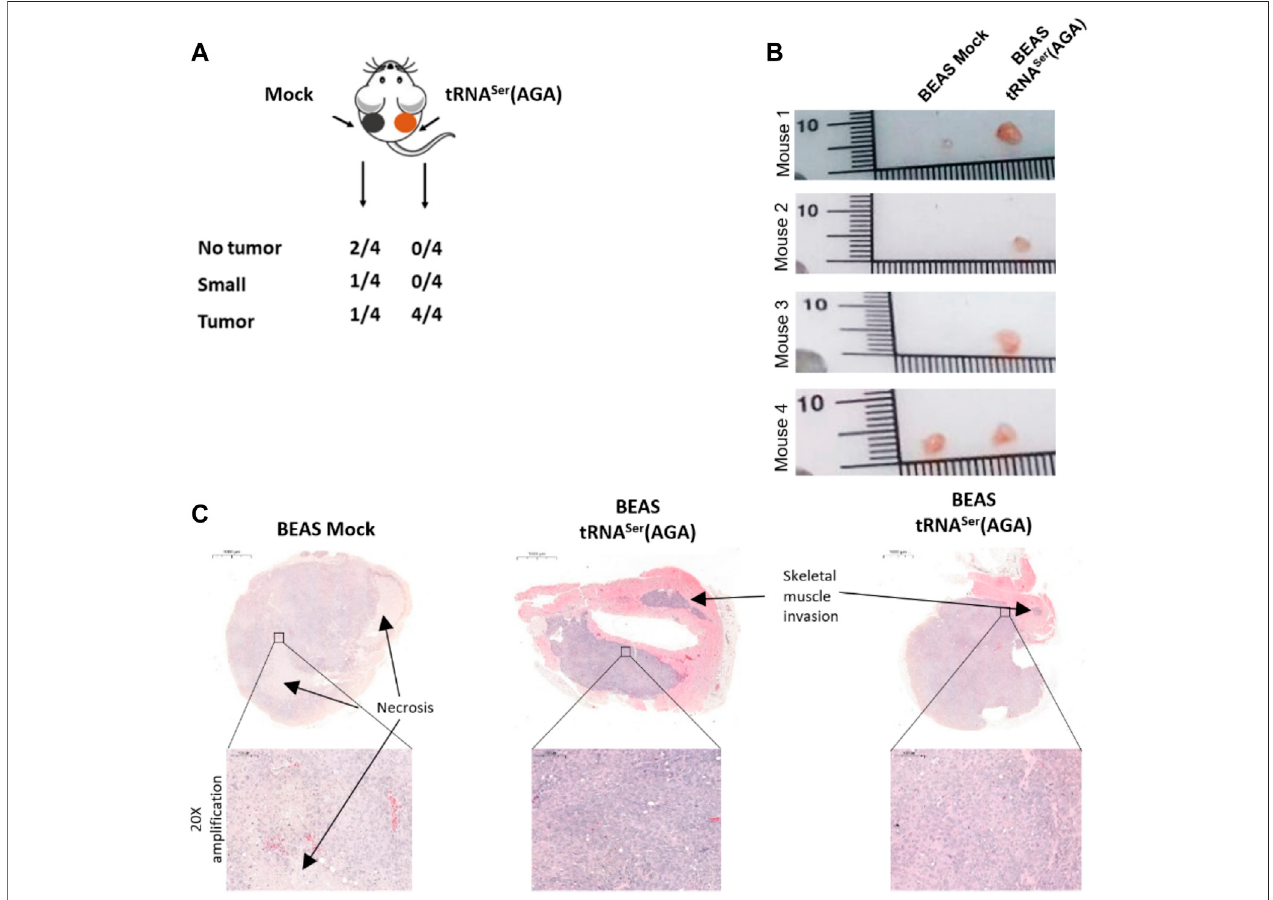
FIGURE 4 | Effect of tRNA deregulation in tumor initiation. (A) All animals inoculated with BEAS-2B cells harboring the recombinant tRNA Ser (AGA) developed a tumor, whereas only 50% of the mice had BEAS-2B Mock tumors of small size. (B) Macroscopy imagens of Mock and tRNA Ser (AGA)-derived tumors inoculated in the same animal (C) H&E of Mock and tRNA Ser (AGA)-derived tumors. Upper part, Digitalization of whole tumors with indication (~3.3x ampli fi cation) of Skeletal Muscle invasion and Necrotic areas. Bottom part. 20x ampli fi cation of indicated tumoral